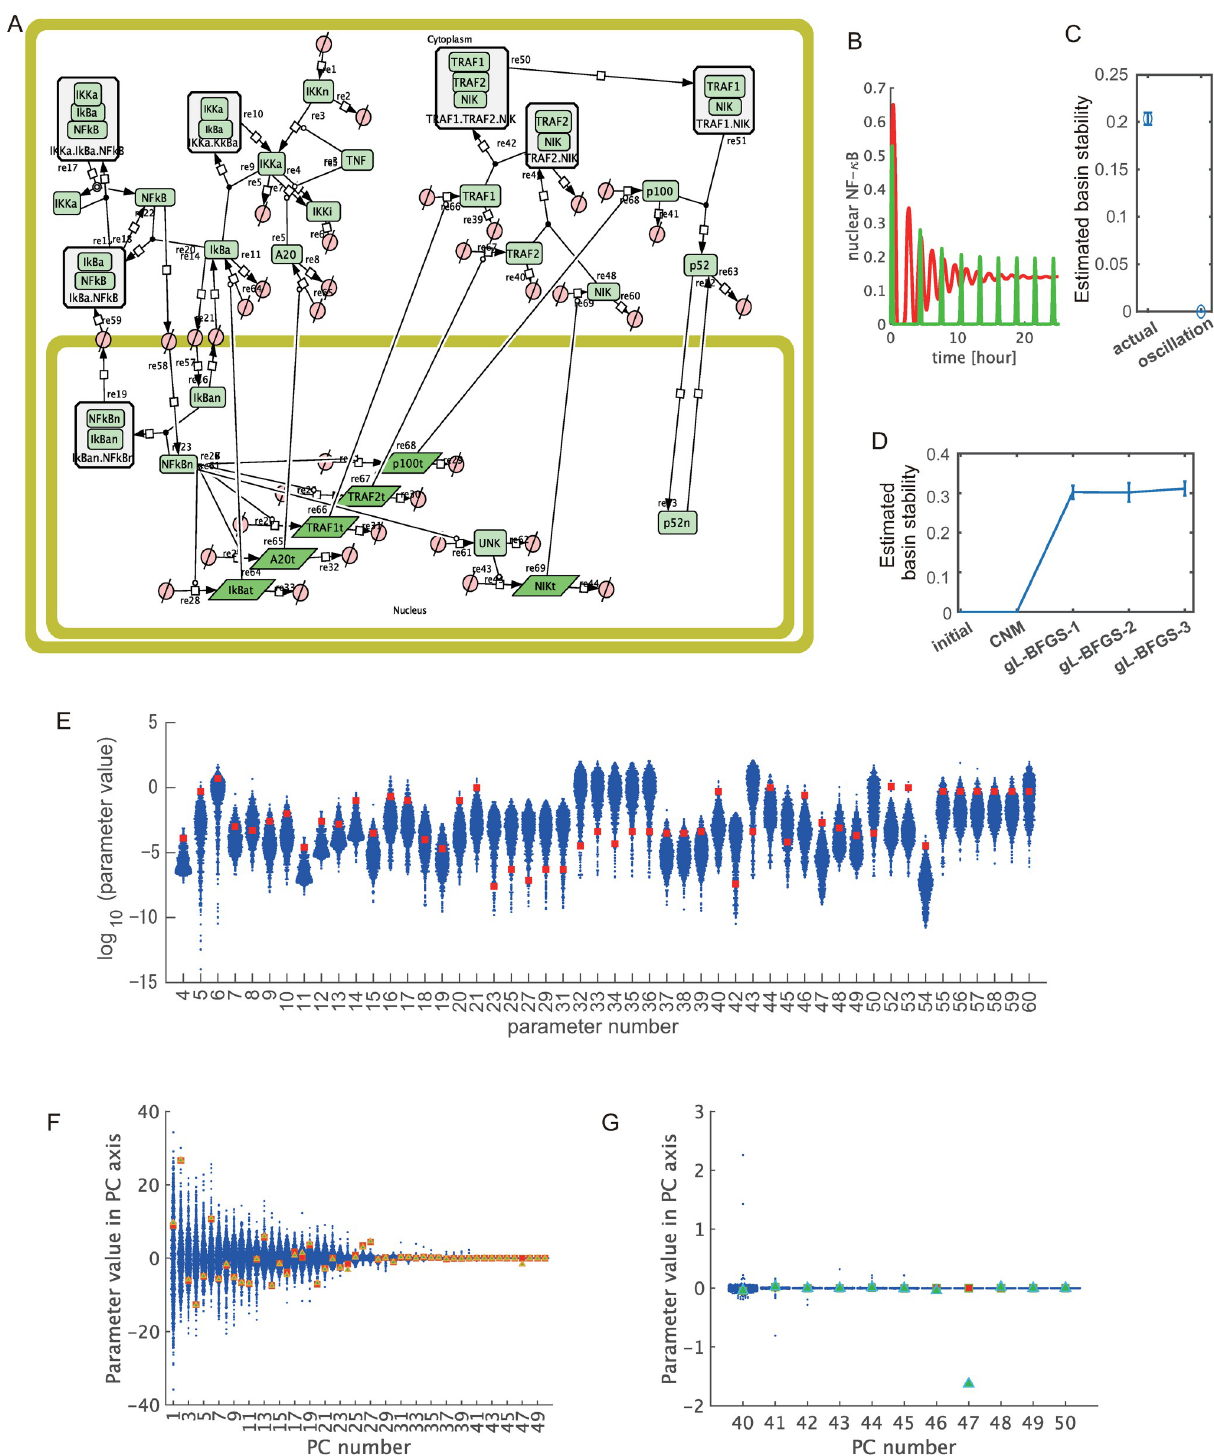
Fig 5. Application of TEAPS for NF- κ B signaling pathway model. (A) The model structure of NF- κ B signaling pathways. This signaling pathway includes feedback inhibition of NF- κ B activation through I κ B α and A20. (B) Time courses of NF- κ B activation. The parameter set fitting to in vitro observation outputs a damped oscillation as is consistent with experimental observation (red), while the model outputs continuous oscillation when the parameter related to feedback inhibitions are changed (green). (C) The estimated basin stability for the reported parameter set (actual) and the parameter set outputting continuous oscillation (oscillation). (D) The estimated basin stability was increased by individual optimization process